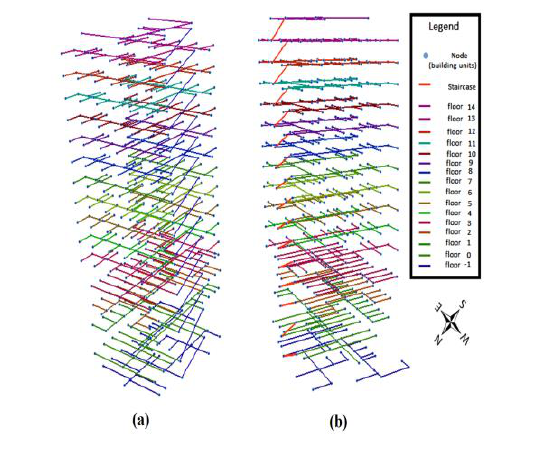
Figure 8. 3D model of Plasco building (a) southern view (b) northern view